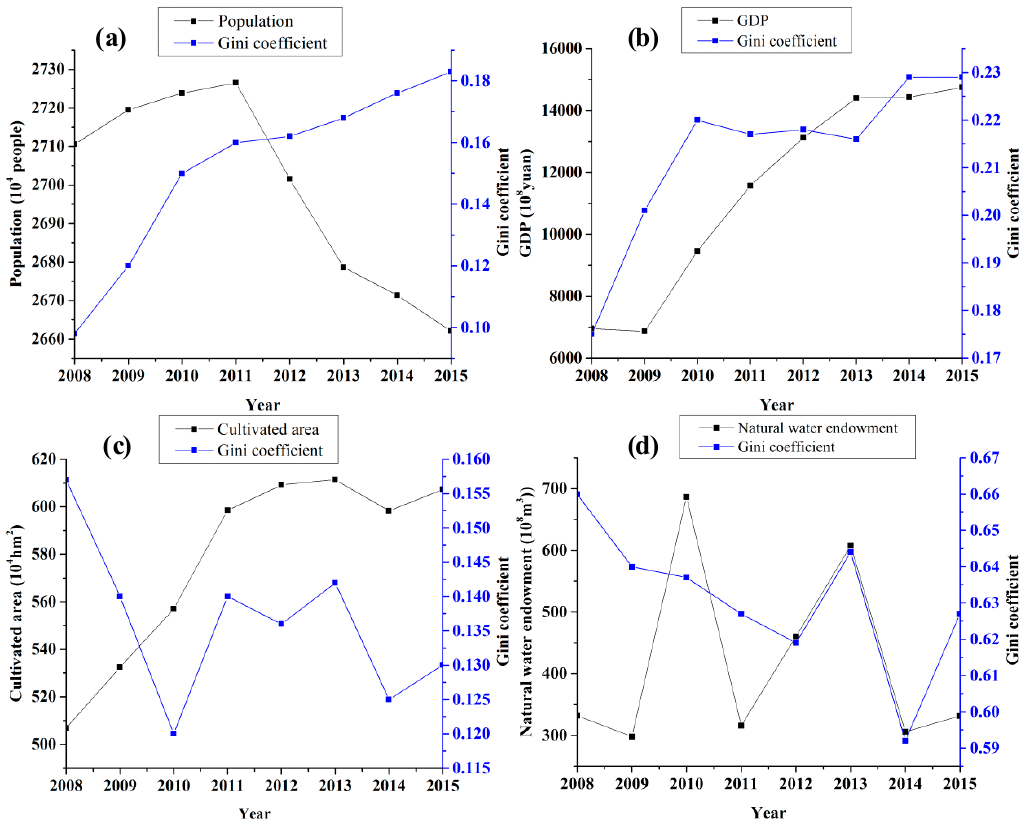
Figure 6. Trends of WF inequality and influencing factors in Jilin Province from 2008 to 2015: ( a ) population and the Gini coefficient between WF and population; ( b ) GDP and the Gini coefficient between WF and GDP; ( c ) cultivated area and the Gini coefficient between WF and cultivated area; ( d ) natural water endowment and the Gini coefficient between WF and natural water endowment.